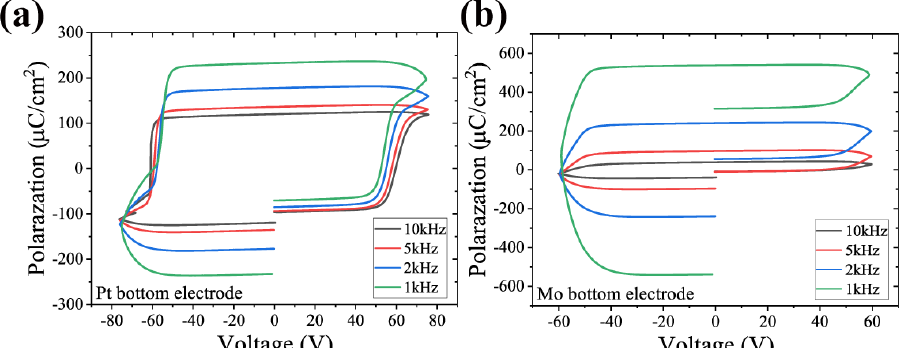
Figure 7. The hysteresis P-E loops with different frequencies of the Al 0.7 Sc 0.3 N on ( a ) Pt—as the frequency increases, the polarization flips incompletely and gradually becomes symmetrical—and ( b ) Mo—always